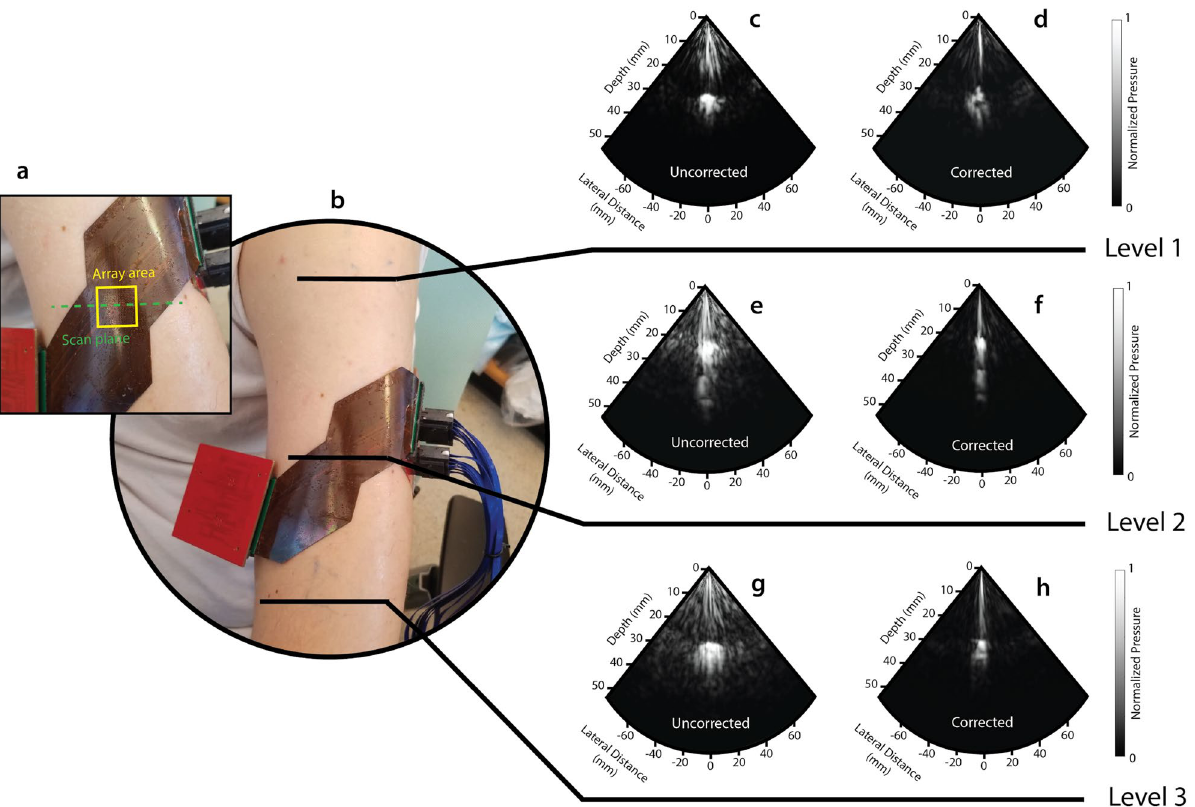
Figure 6. Imaging of the human humerus with the FlexArray. ( a ) Close-up photograph of the array area on the arm during imaging, also showing the 2D plane along which the scan was taken. ( b ) Photograph of the subject’s arm with the device in the Level 2 position. Three levels were chosen to image the bone along the length of the arm. ( c , d ) Level 1 B-mode images of the humerus without and with correction for the radius of curvature of 4 cm, respectively. Analogous images were taken at ( e , f ) Level 2 and ( g , h ) Level